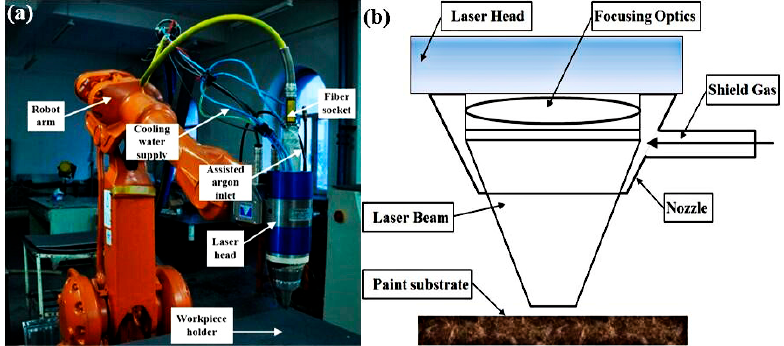
Figure 1. Schematic diagram of experimental setup. ( a ) Actual experimental equipment. ( b ) Laser-nozzle-substrate arrangement used in the experiments.